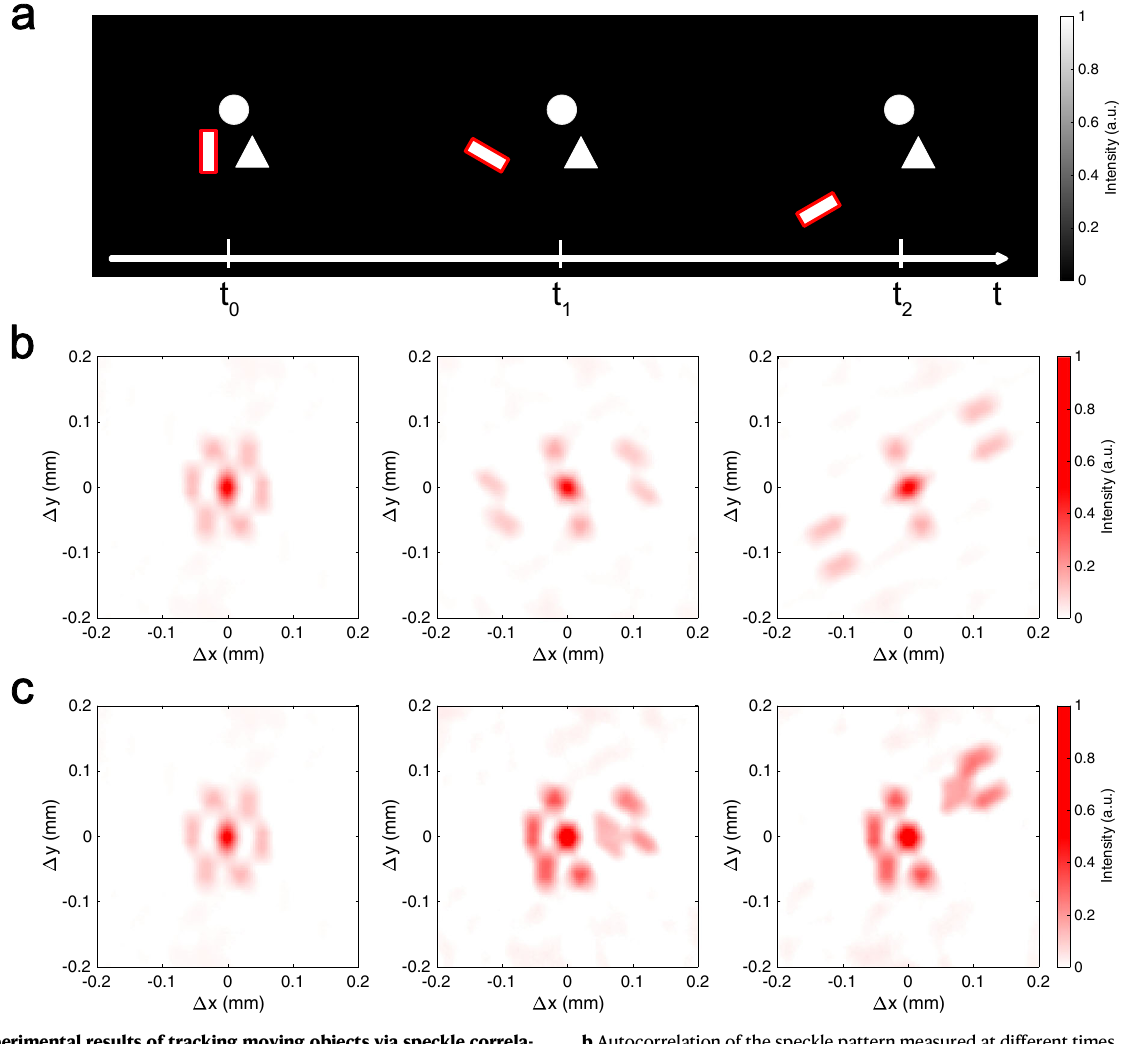
b Autocorrelation of the speckle pattern measured at different times, and c cross- correlation between the measured speckle at time t 0 and that at time t n (see Supplementary Video